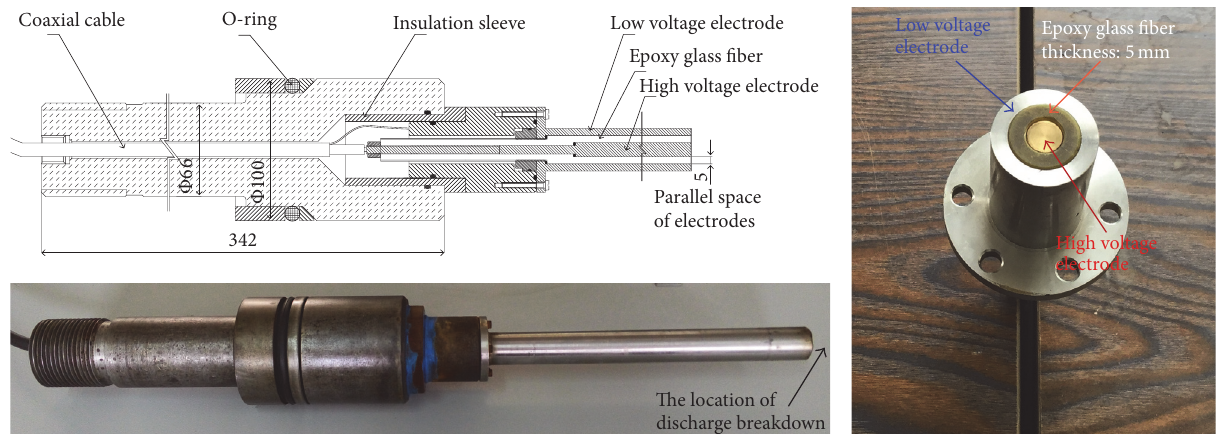
Figure 4: Picture of the real electrode and its structural diagram.